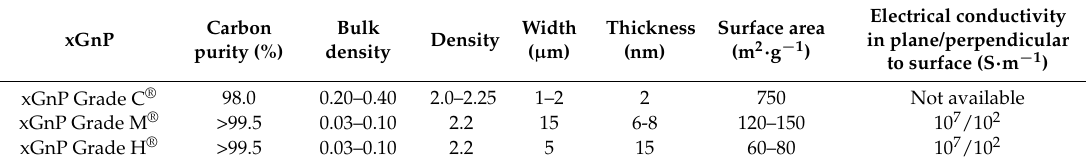
Table 1. Properties of the as-received graphite